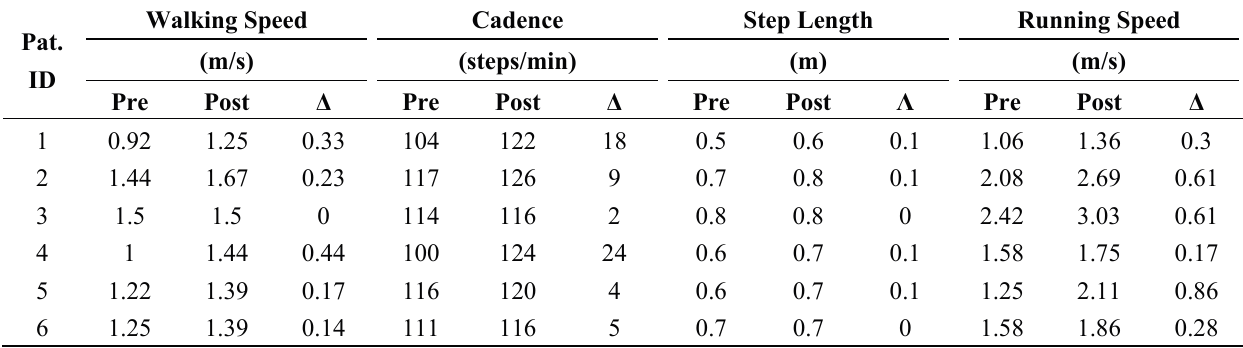
Table 2. Spatiotemporal gait parameters for normal walking and running on a level surface before (Pre) and 12 months after (Post) surgery (mean